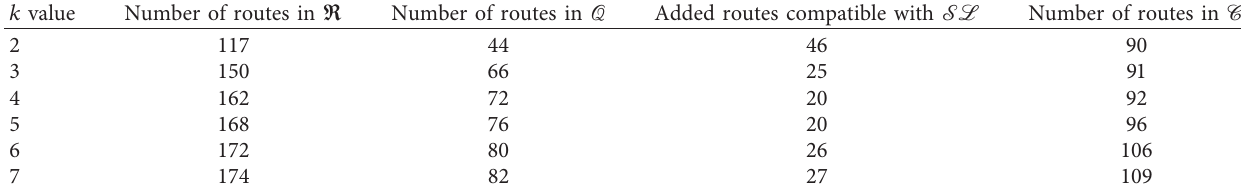
Table 4: Number of routes that appear with the application of the proposed algorithm according to the k value in the best solution in each case study.